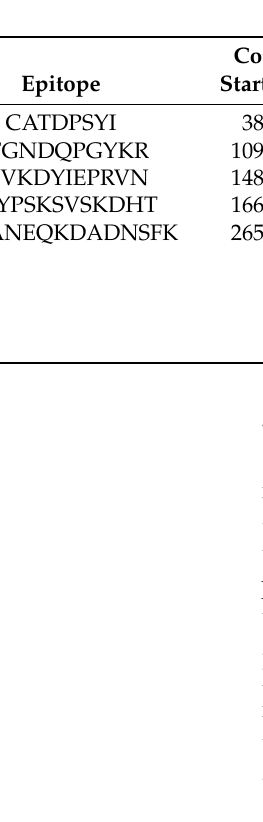
Table 3. Filtered MHC-I peptides of CotH and SP proteins.